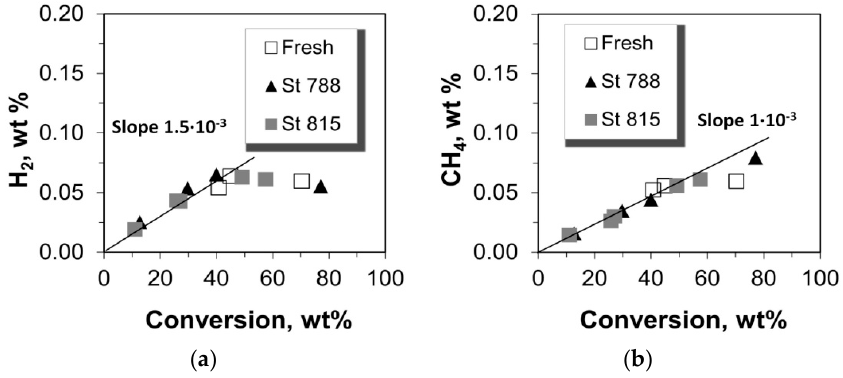
Figure 7. Production yields of ( a ) hydrogen and ( b ) methane versus the conversion of n-C 12 .